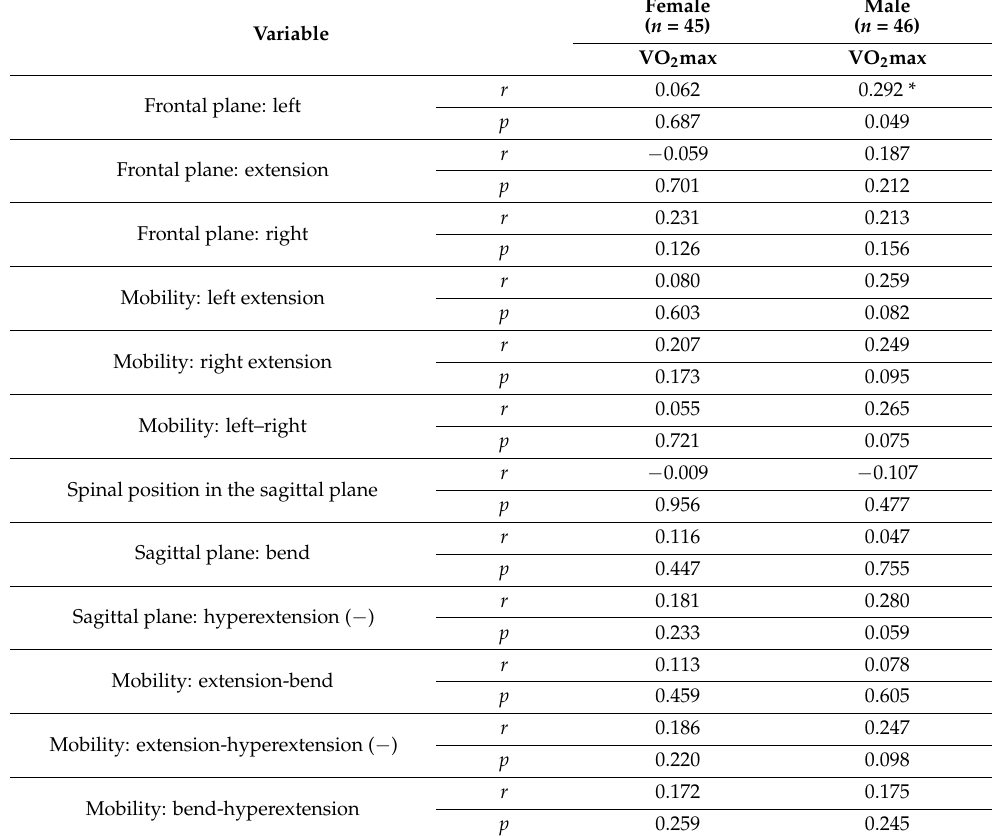
Table 7. Results of Pearson’s r correlation test examining relationships between maximal oxygen uptake and the spinal range of mobility in the sagittal and frontal planes.